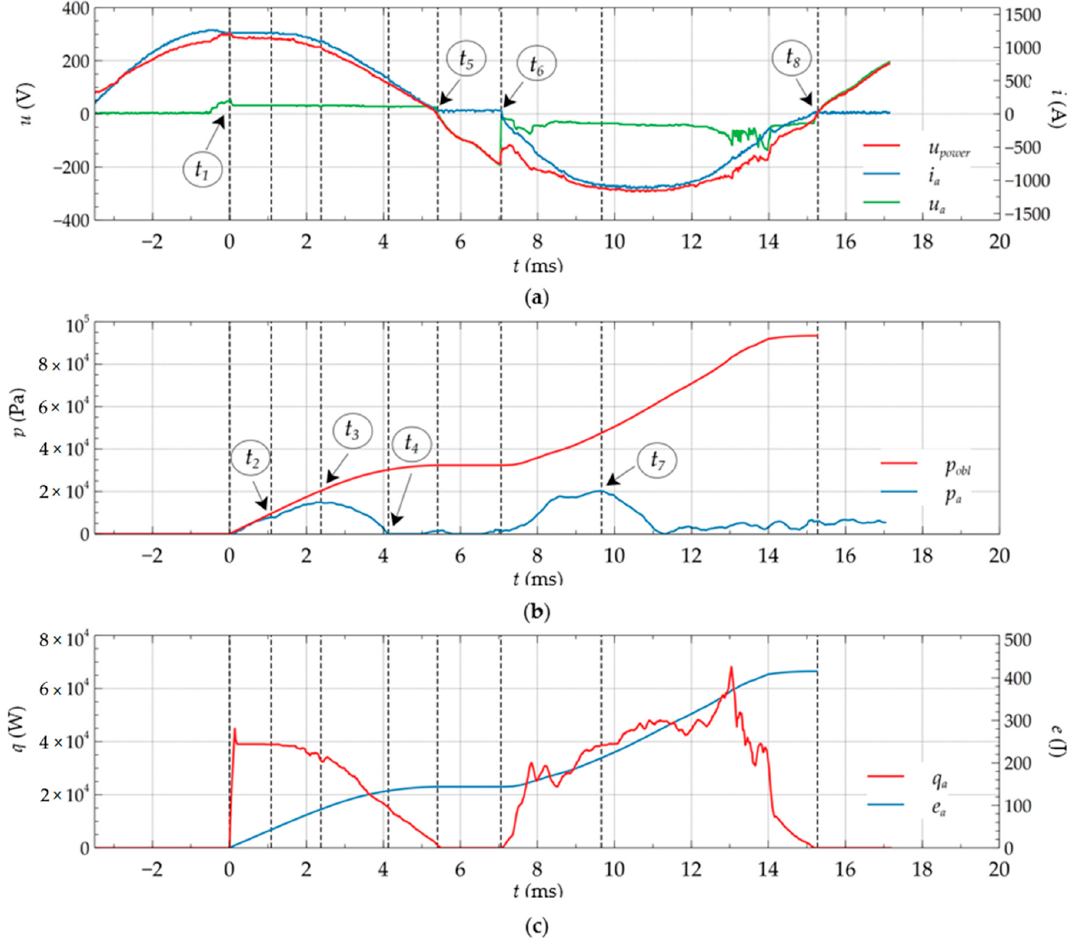
Figure 4. Waveforms as a function of the arc fault duration: ( a ) supply voltage u power , arc voltage u a and current in the arc Figure 4 branch i a ; ( b ) measured and calculated pressure p a and p obl inside the junction box casing; ( c ) power consumption by the arc q a , and energy released on the arc e a as a function of the duration of the arc fault. Points t 1 –t 8 correspond to the successive photographic images a–h presented in Figure